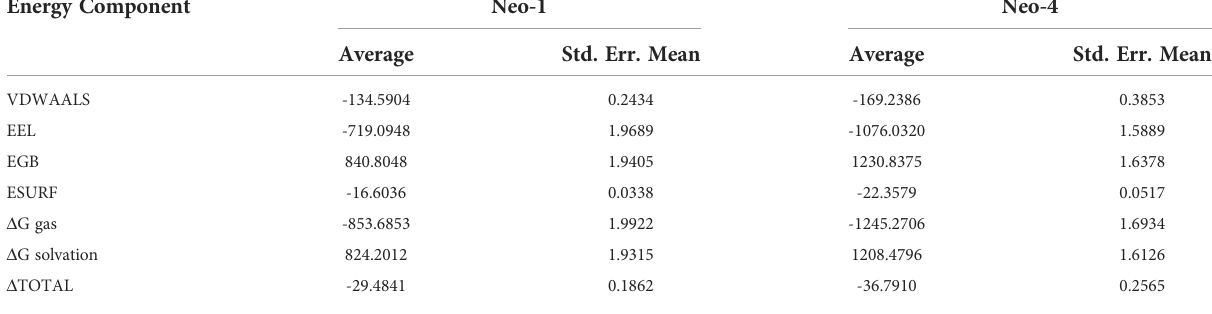
TABLE 8 MM/GBSA free energy estimation and individual free energy components of vaccines-TLR3